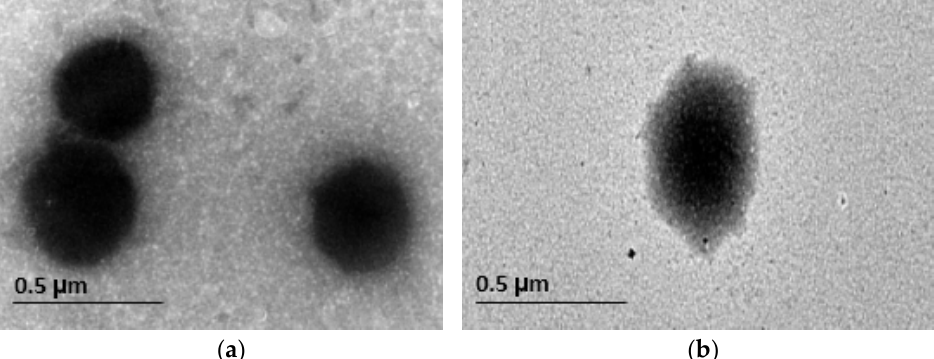
Figure 3. Transmission electron micrographs of: ( a ) DCN-loaded vesicles (without HA); ( b ) optimized DCN-loaded hyaluosome (with gel core).